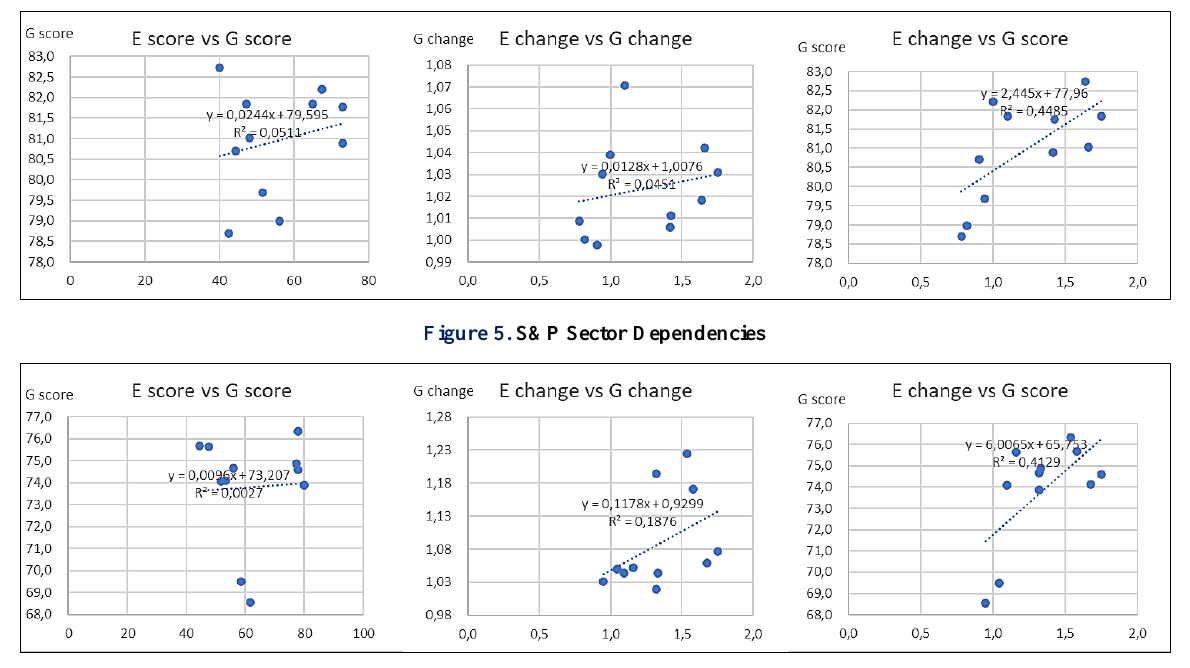
Figure 6. Stoxx Europe 600 Sector Dependencies